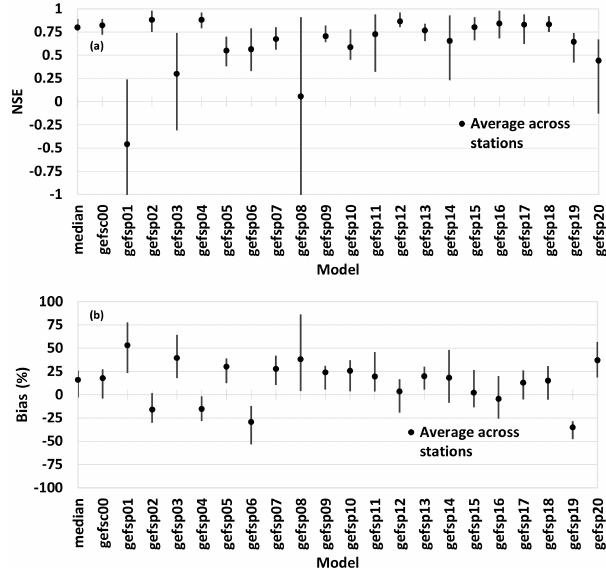
Figure 8. Overall NSE and BIAS (%) across the stations for forecast issued 24h before Hurricane